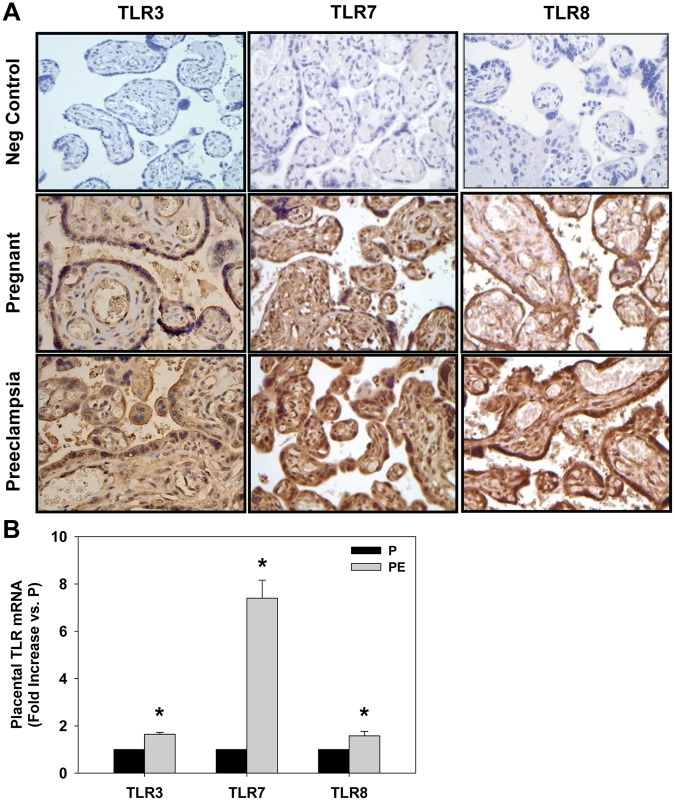
Increased TLR3/7/8 immunoreactivity and mRNA levels in placentas of women with preeclampsia.(A) Representative images where brown staining indicates immunoreactivity and blue indicates hematoxylin staining of nuclei in placentas from pregnant (P, n = 13, top panels) and preeclamptic (PE, n = 17, bottom panels) women. (B) mRNA levels of TLR3, TLR7, and TLR8 in placentas from PE and P women. Results are expressed as mean + SEM. *p<0.05 vs P.